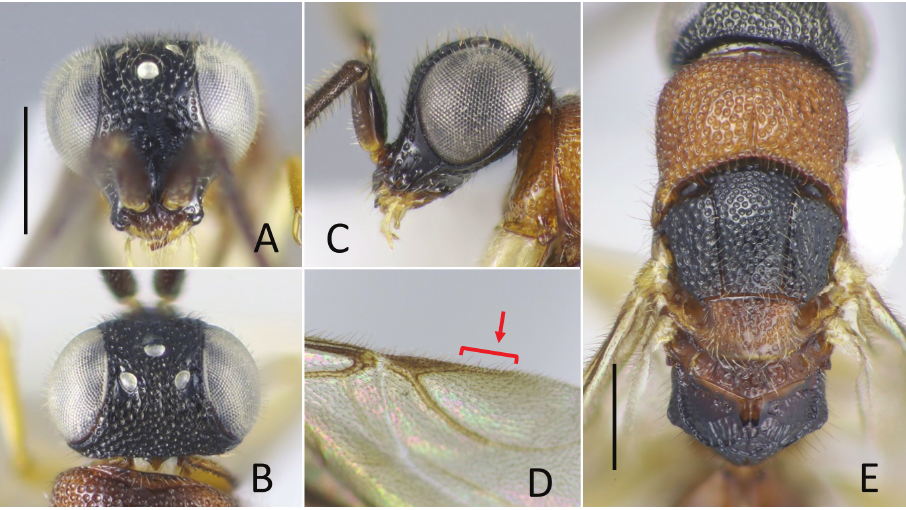
Figure 11. Okinawasega eguchii Terayama ♂ A head in frontal view B ditto, dorsal view C ditto, lateral view D forewing E mesosoma. Scale bars: 0.5